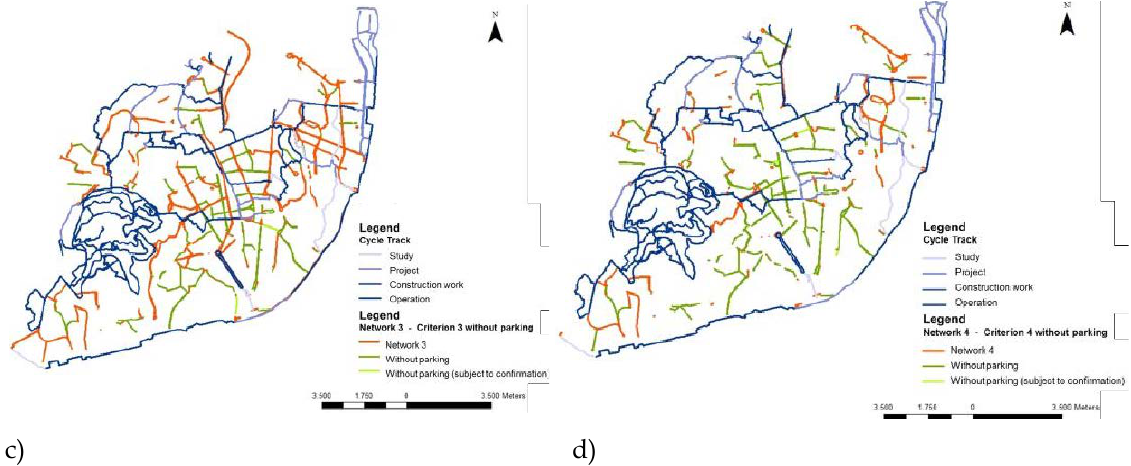
Figure 6. Road network rearrangement for cycle network according to different criteria: (a-d) for criteria 1 to 4, respectively, while removing parking places also